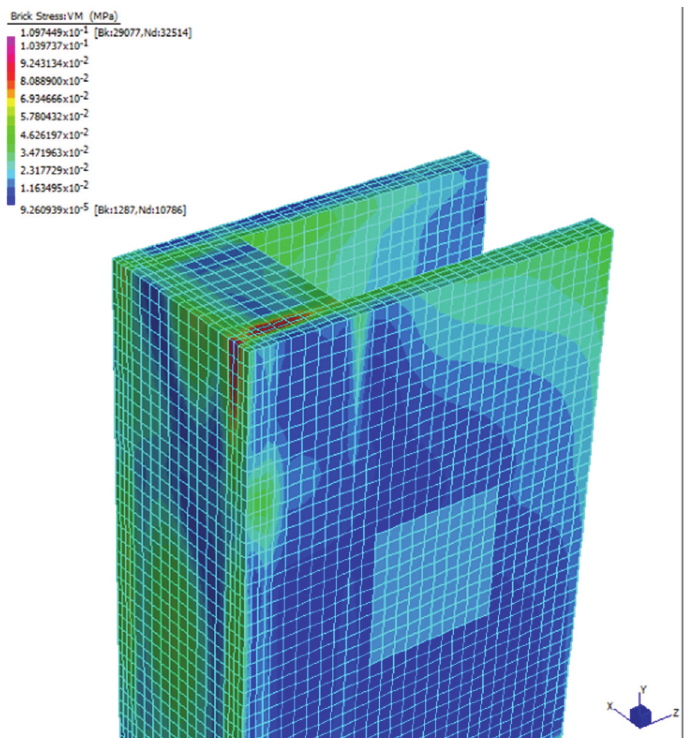
Fig. 11: Peak Stresses in the